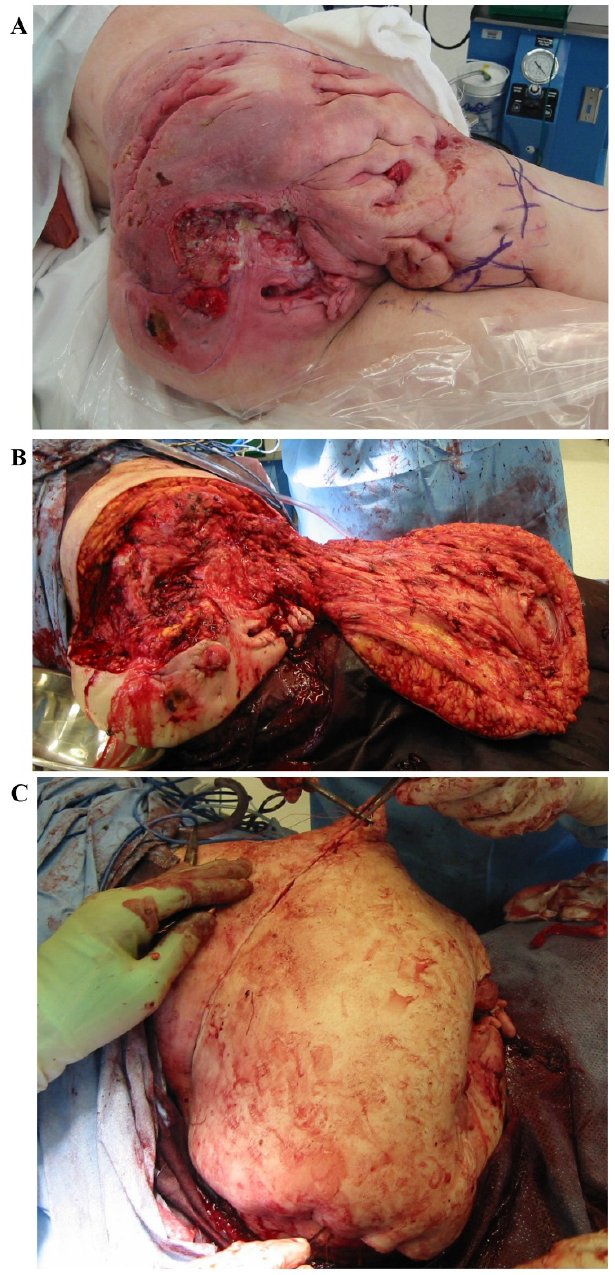
Figure 2. A. This patient had Crohn’s Disease with multiple fistulae extending from the bowel to the pelvis and right hip joint. The right sacro-iliac joint was exposed. B. The pelvic osteomyelitis was treated by radical excision including the right hemipelvis, the right hip and lower limb. The anterior thigh muscles were preserved on the healthy femoral vessels. C. The defect was directly closed using the thigh musculocutaneous